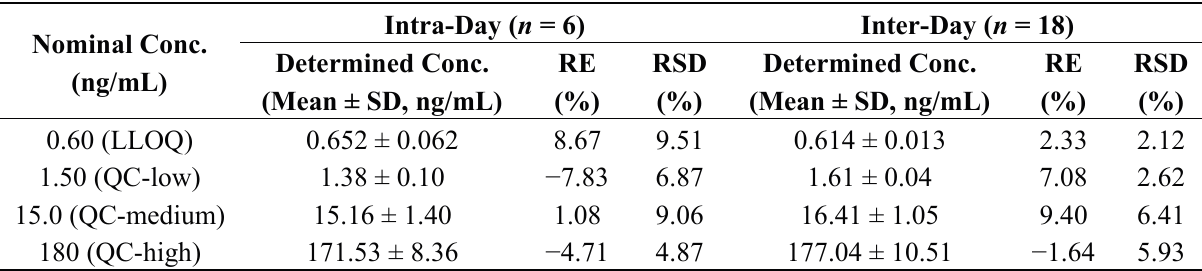
Table 1. Intra- and inter-day accuracy and precision for determination of PDC in rat plasma. Nominal Conc.